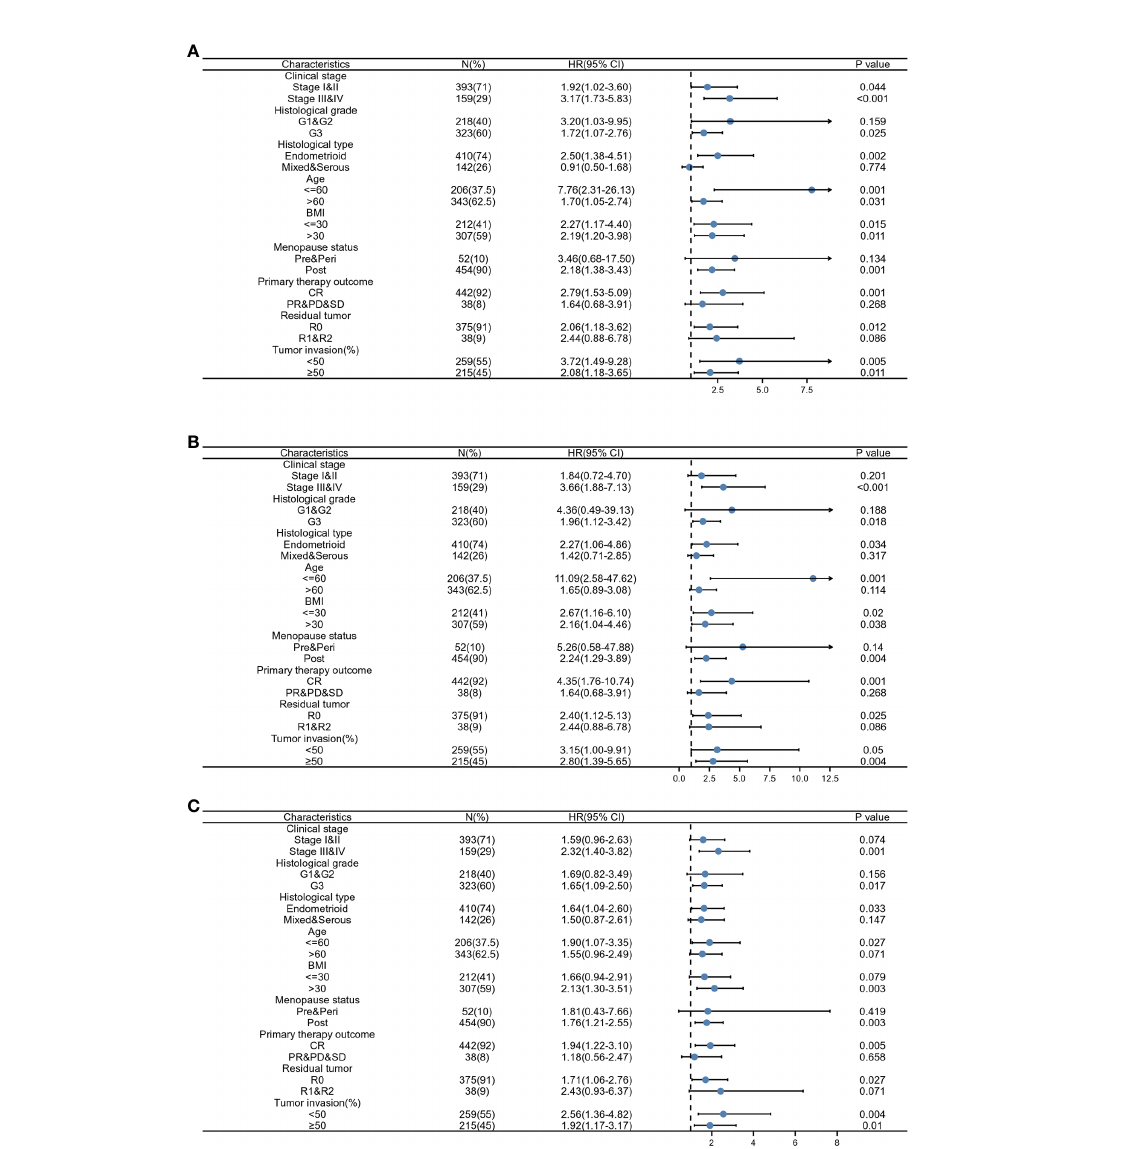
FIGURE 6 Prognostic performance of RPP40 on clinical outcomes in different subgroups of UCEC patients. Patients were divided into different subgroups according to clinical stage, histological grade, histological type, age, BMI, menopause status, primary therapy outcome, residual tumor, and tumor invasion. For each subgroup, the prognostic performance of RPP40 on OS (A) , DSS (B) , and PFI (C) were evaluated by Cox regression, and the results are presented as a hazard ratio. The bar represents the 95% con fi dence interval of the hazard